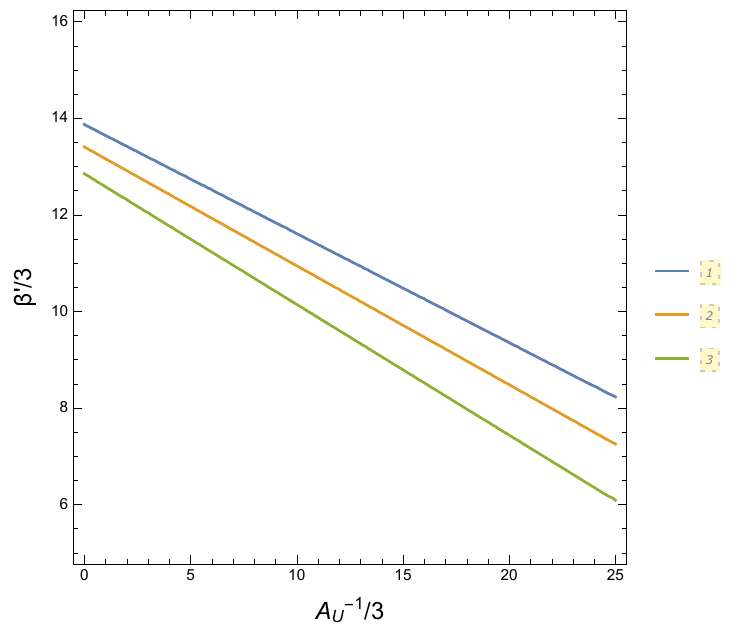
Figure 2 . Contours for trinification breaking scale. The abscissa represents values for (3 A U ) − 1 which is proportional to the difference of the inverse gauge couplings α L,R at the unification scale M U (see text). On the ordinate are the values for the difference of the corresponding beta functions β ′ / 3. Curve (1) corresponds to M R 10 4 GeV, curve (2) to M R 10 5 GeV, and curve (3) to ∼ ∼ M R 10 6 ∼